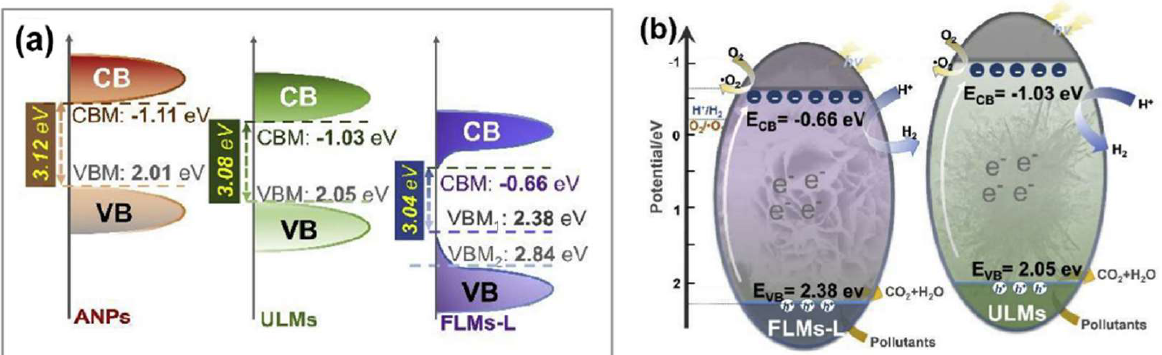
Figure 4. ( a ) Assumed band structures of the shape-controlled SrTiO 3 photocatalysts. ( b ) Proposed mechanism for the photocatalytic hydrogen evolution over the shape-controlled SrTiO 3 [70] . Reprinted/adapted with permission from Elsevier, 2019.